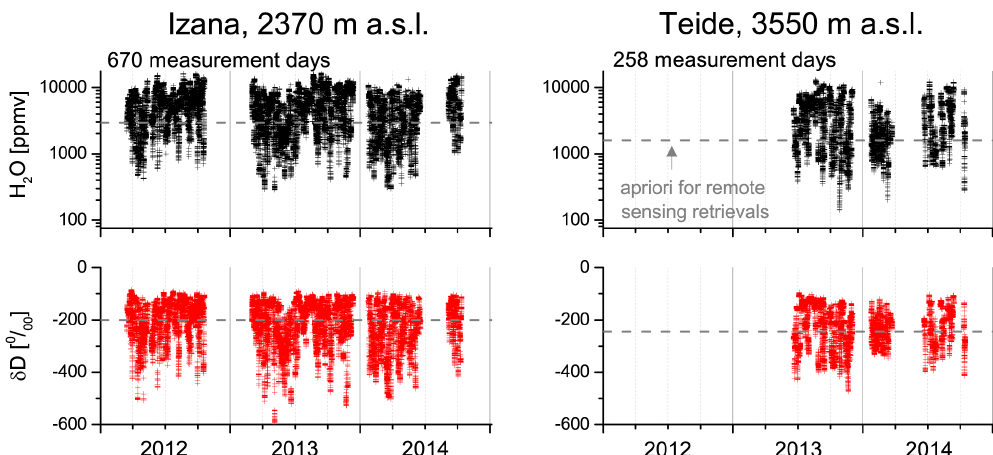
Figure 2. H 2 O (upper panel) and δ D data (bottom panel) as measured by the Picarro instruments on Tenerife between midnight and 1 hour after sunrise. The depicted data are 10min averages obtained during a large amount of different days (numbers as given in the panel). For comparison we also depict the a priori values used for the MUSICA NDACC/FTIR and METOP/IASI remote sensing retrievals (grey dashed